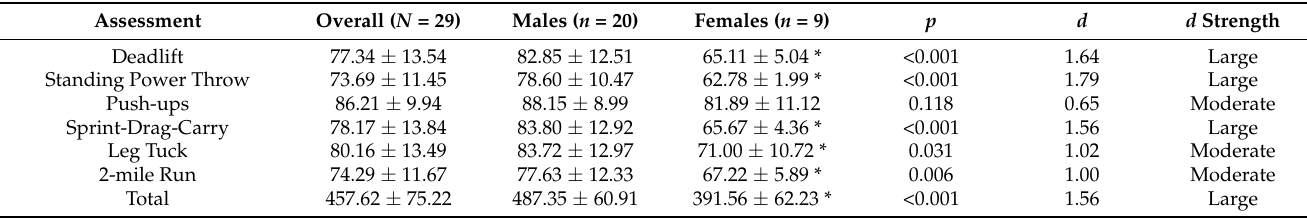
Table 2. Descriptive data (mean ± SD) for the Army Combat Fitness Test event (3-repetition maximum deadlift (deadlift), standing power throw, hand-release push-ups (push-ups), sprint-drag-carry, leg tuck, 2-mile run) scaled and total point scores for the overall group, males, and